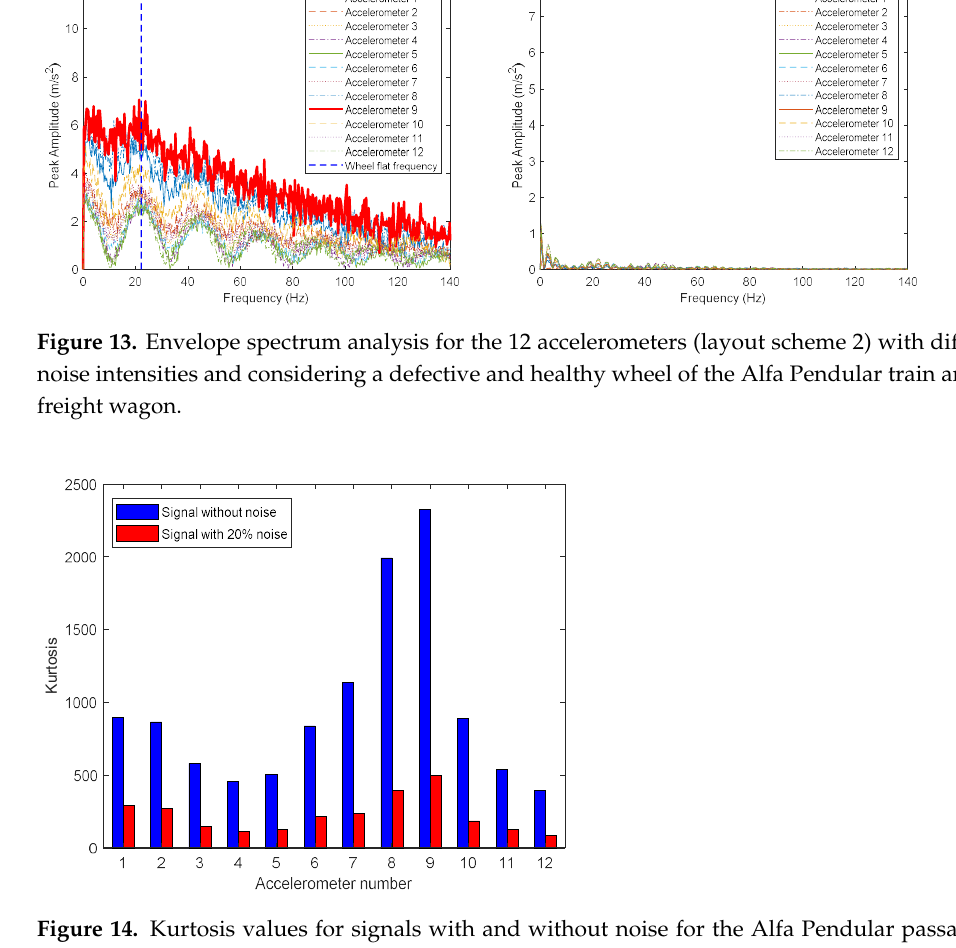
Figure 14. Kurtosis values for signals with and without noise for the Alfa Pendular passage for layout scheme 2.